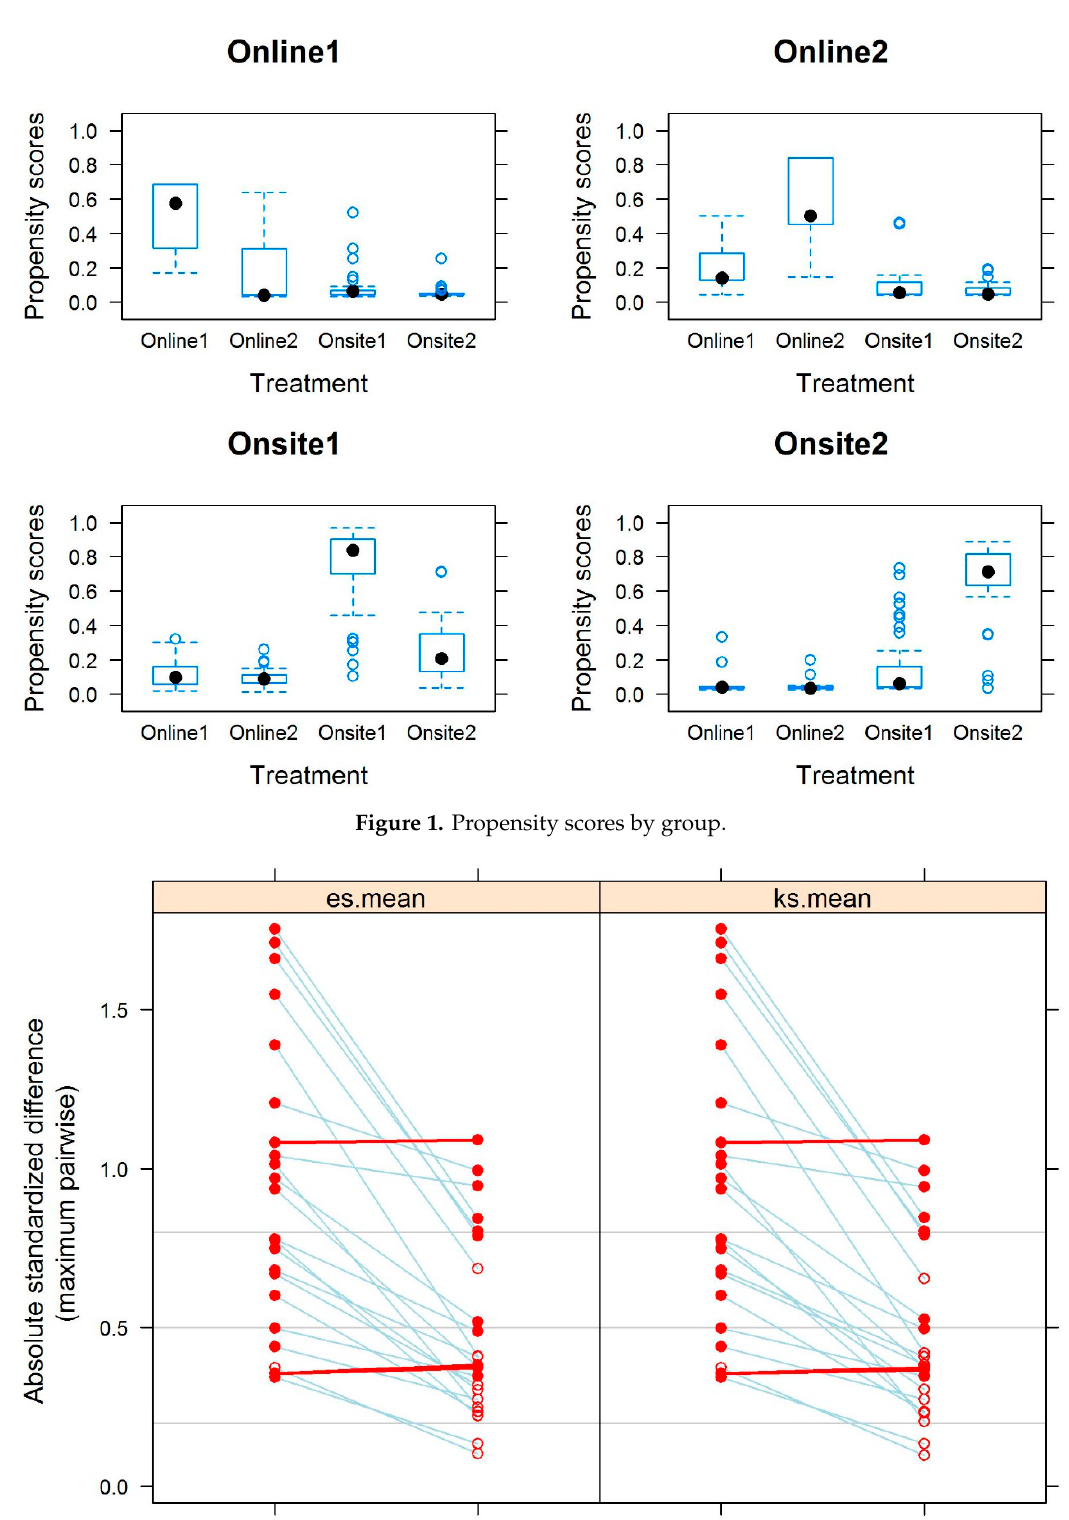
Figure 2. Standardized mean di ff erence between inverse probability of treatment (IPTW) model and unweighted data.